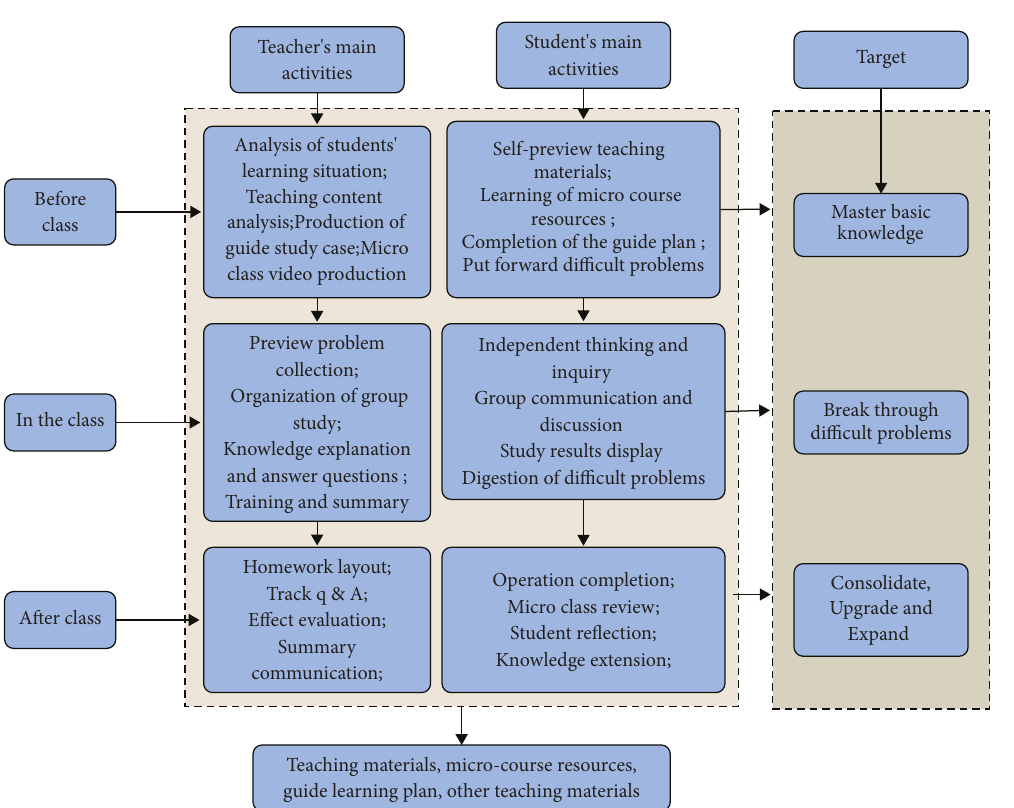
Figure 10: The English teaching model of the interactive integration of guided study plans and microlectures.